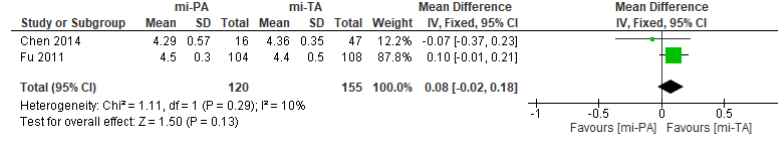
measure of effect is plotted as a diamond with lateral points indicating confidence intervals.